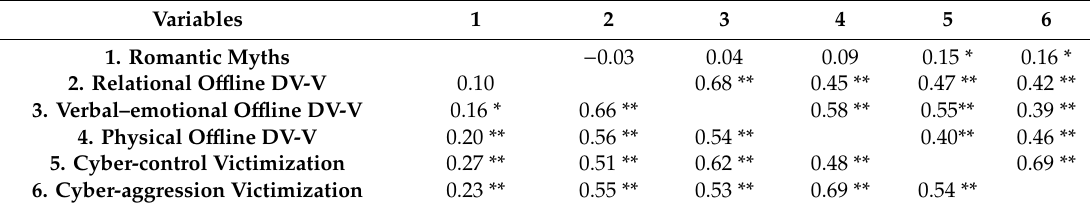
Table 1. Pearson’s Correlations among Variables (Boys Above the